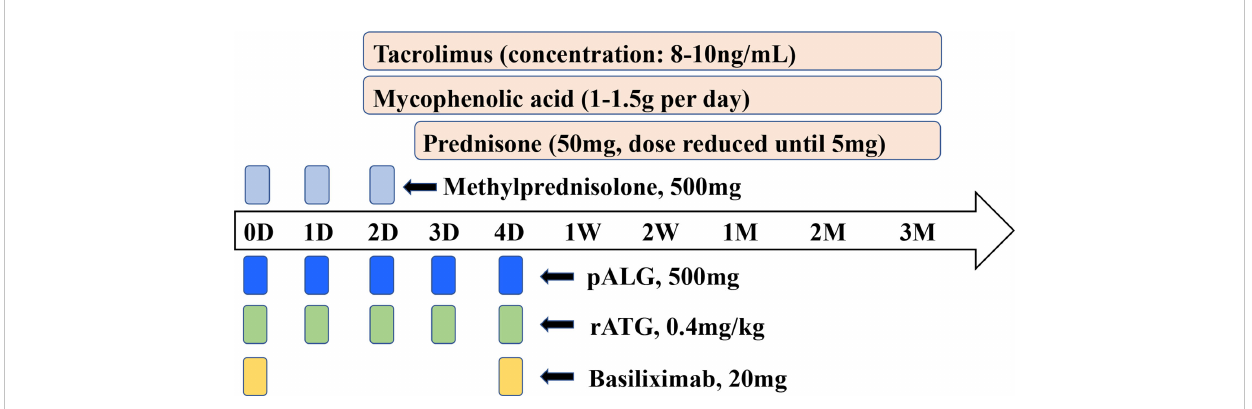
FIGURE 1 Induction therapy and immunosuppressive protocol for kidney transplantation. Induction therapy was provided using pALG, rATG, basiliximab or untreated. Methylprednisolone was administrated at a daily dose of 500mg to all recipients from POD0 to POD2. Initial and maintenance immunosuppression therapy was tacrolimus + mycophenolic acid+ prednisone. The dosage and usage were shown. D, day. W, week. M,